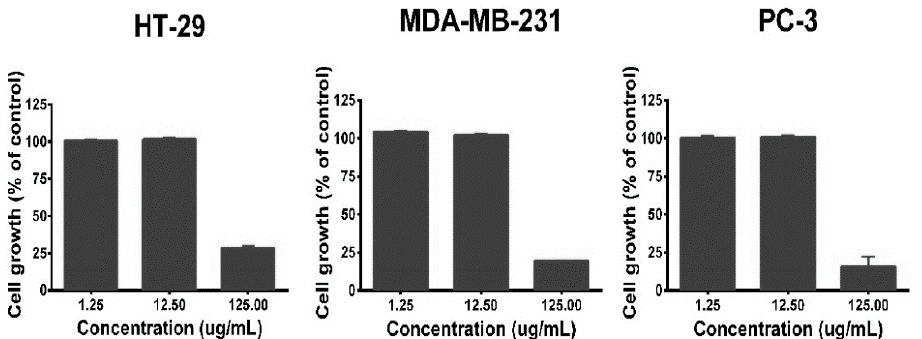
Figure 2. Antiproliferative activity of the extract obtained from the ‘sugar mango’ seed coat. Cell lines: HT-29 (colorectal adenocarcinoma), MDA-MB-231 (breast adenocarcinoma), and PC-3 (prostate cancer).